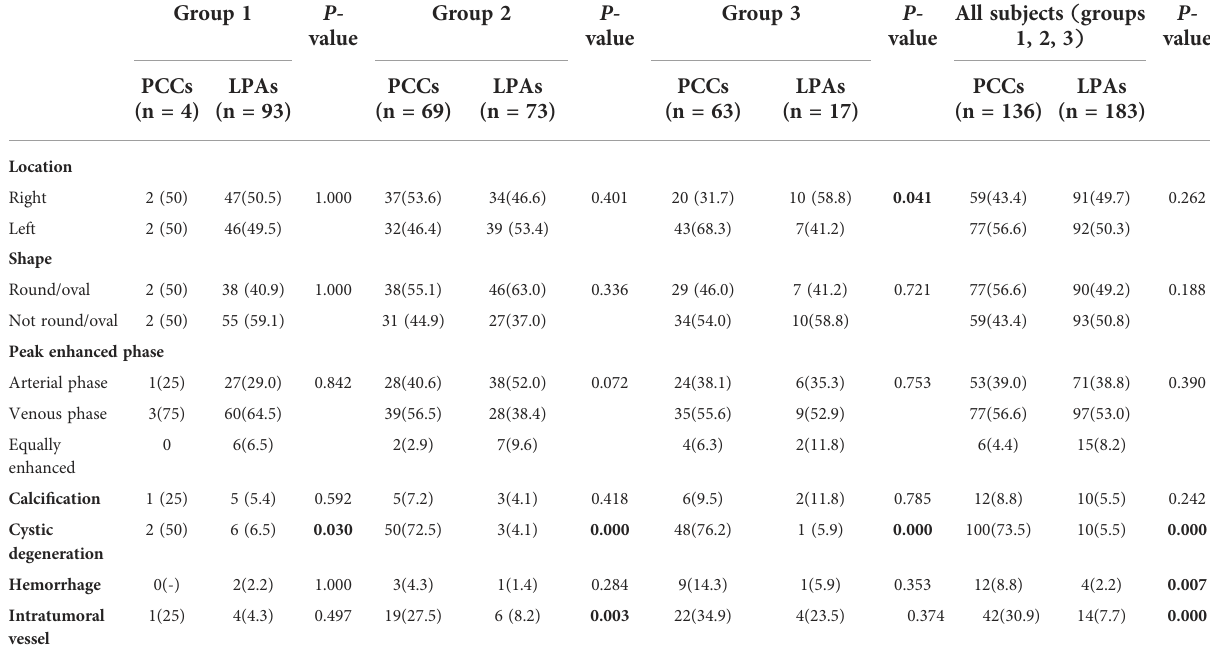
TABLE 3 Qualitative CT features between adrenal PCCs and LPAs on the training